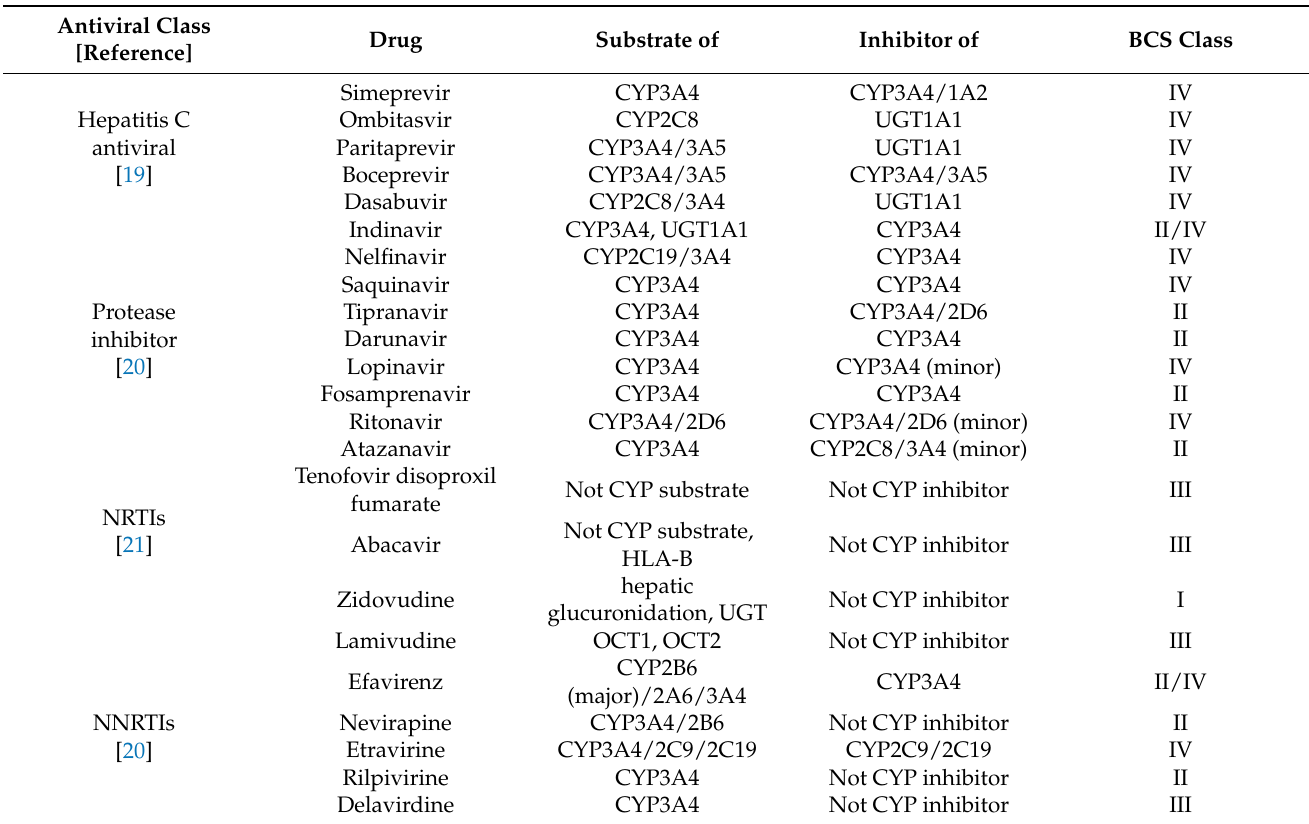
Table 1. Major substrates and inhibitors of